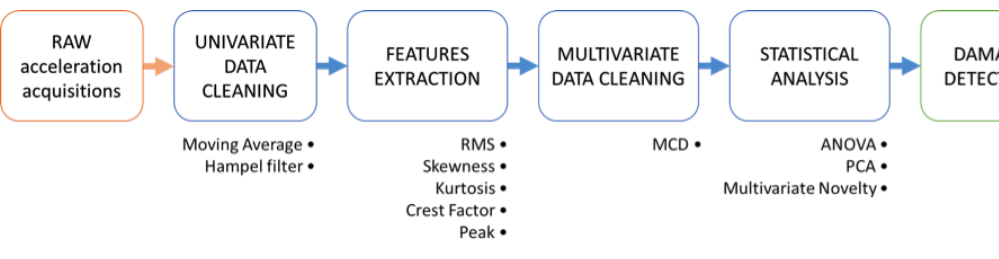
Figure 3. Block diagram of the data analysis